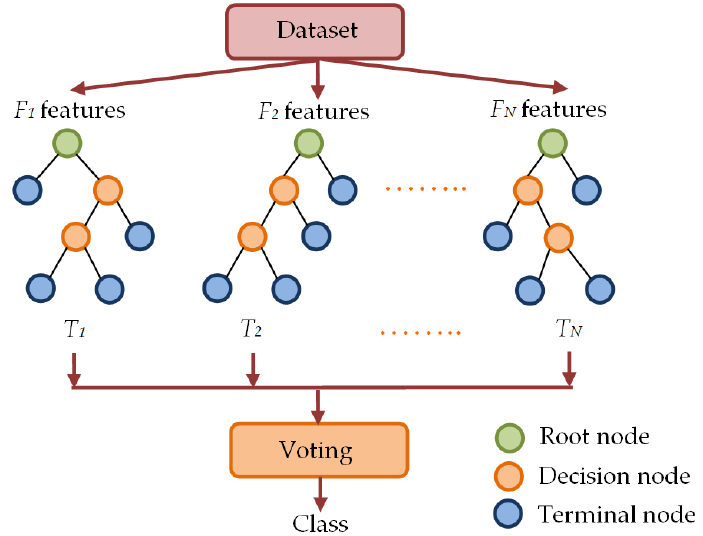
Figure 8. Multiple decision tree ‐ based forest ‐ like structure in RF classifier.